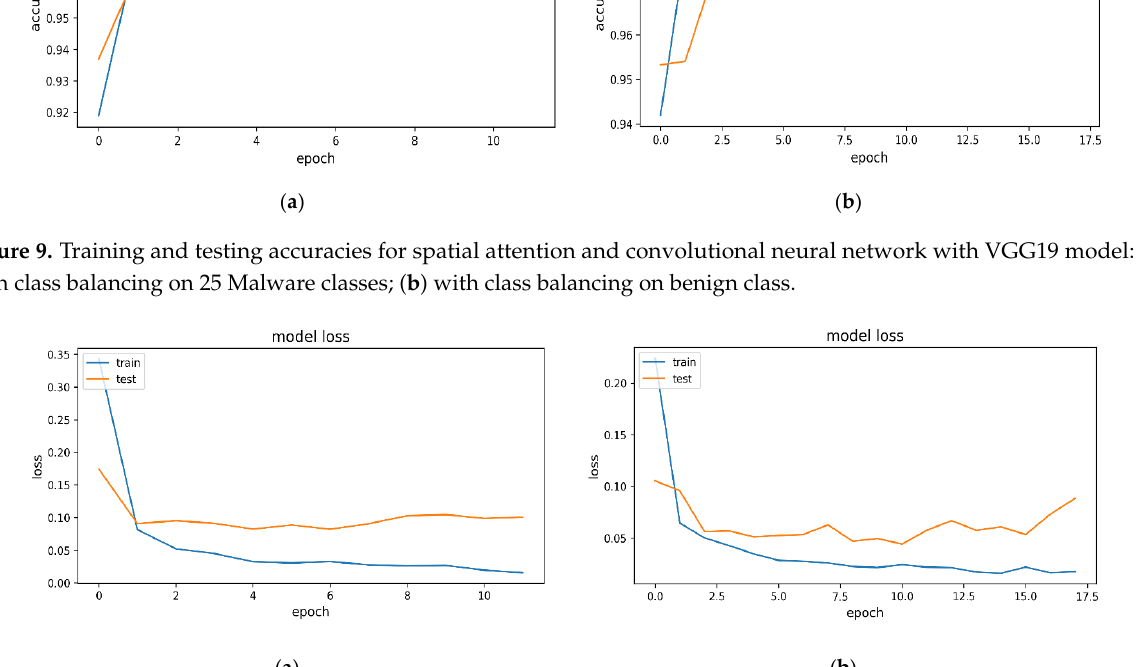
Figure 9. Training and testing accuracies for spatial attention and convolutional neural network with VGG19 model: ( a ) with class balancing on 25 Malware classes; ( b ) with class balancing on benign class.